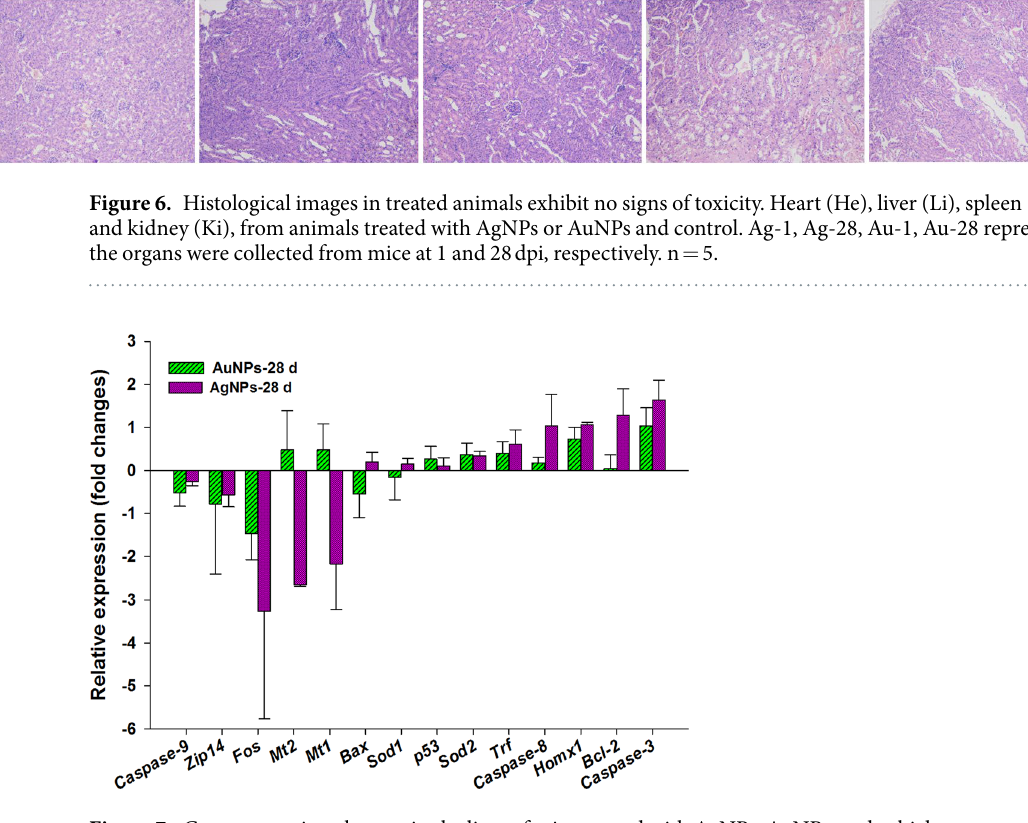
Figure 7. Gene expression changes in the liver of mice treated with AgNPs, AuNPs, and vehicle group on 28 dpi. The relative expression ratio refers to fold changes in the histogram which a ratio greater than zero such as 0.5 indicated gene expression increased by 0.5 time, whereas a ratio below zero indicated